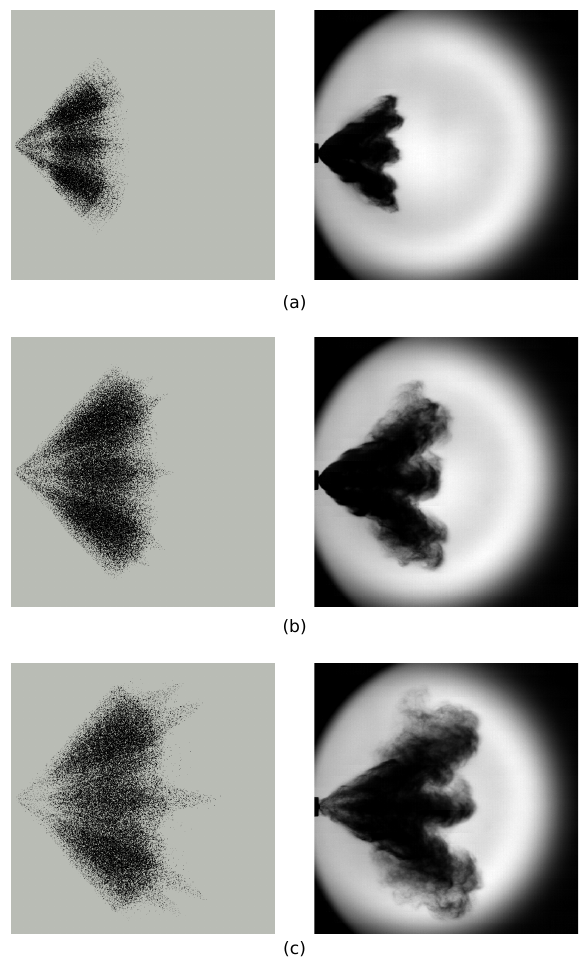
Figure 15. Numerical ( left ) vs. CMT experimental ( right ) liquid morphology images for the G2 cold condition for n–hexane. ( a ) at 0.3ms, ( b ) at 0.6ms, and ( c ) at 0.9ms after